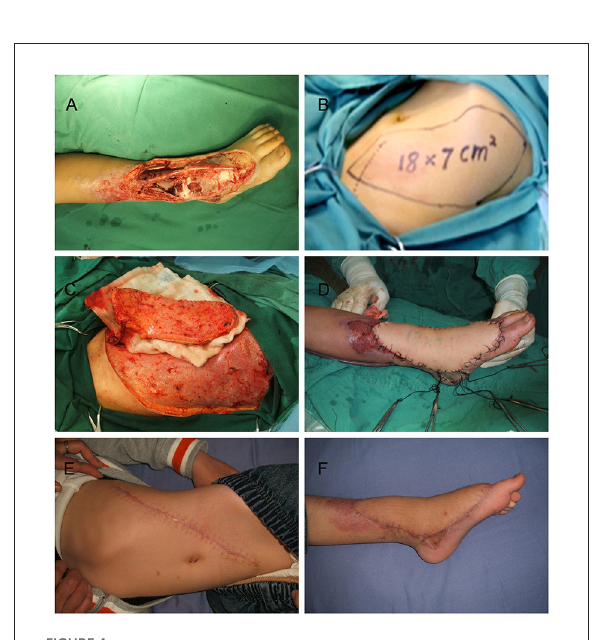
FIGURE4 Images of the 8-year-old boy in case 2. (A) Large soft tissue defects on the left foot and ankle. (B) Oblique deep inferior epigastric perforator flap design. (C) Harvest of the flap. (D) Inset of the flap. (E) Donor site at 5 years postoperatively. (F) Recipient site at 5 years